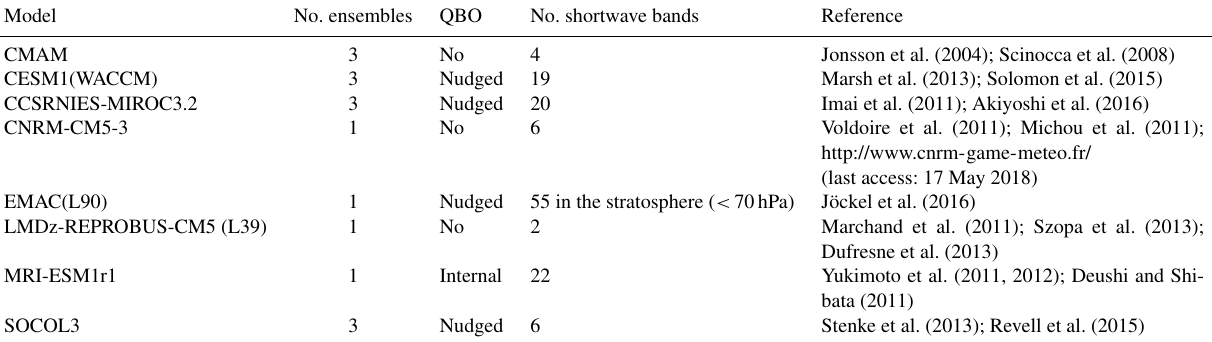
Table 1. Details of the CCMI-1 models used in this study and the number of ensemble members available for the REFC1 experiment for the period 1960–2009. See Morgenstern et al. (2017) for more details. Model No. ensembles QBO No. shortwave bands Reference